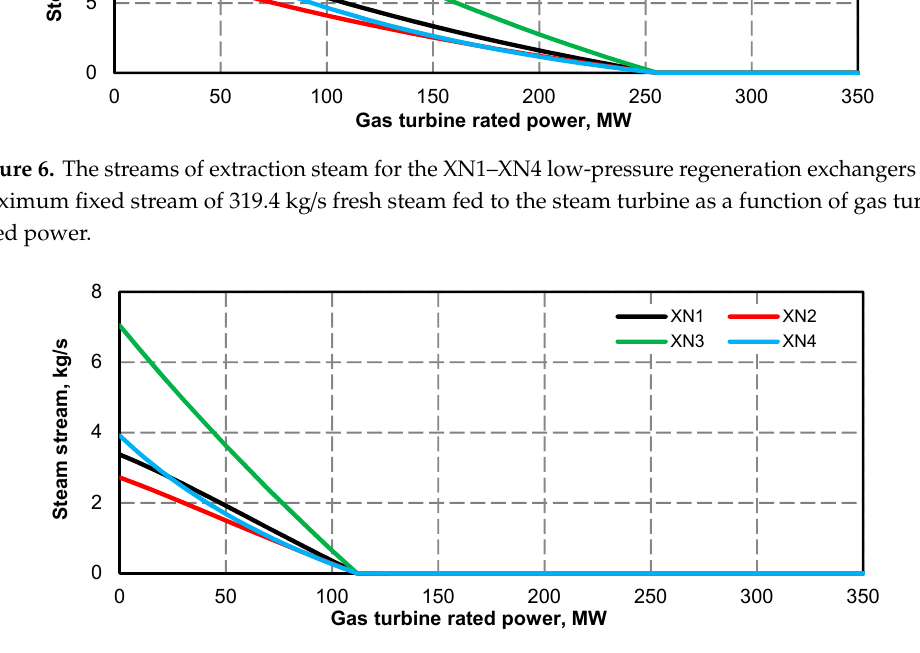
Figure 7. The streams of extraction steam for the XN1–XN4 low-pressure regeneration exchangers for a minimum steam boiler output of 133.3 kg/s and a gas turbine operating at a rated power.